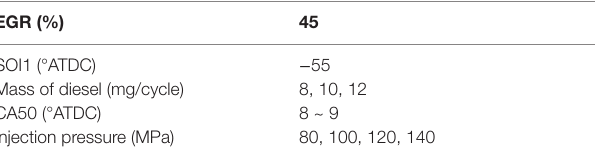
TABLe 2 | Operating conditions for the experiments to extend the load with double injection.